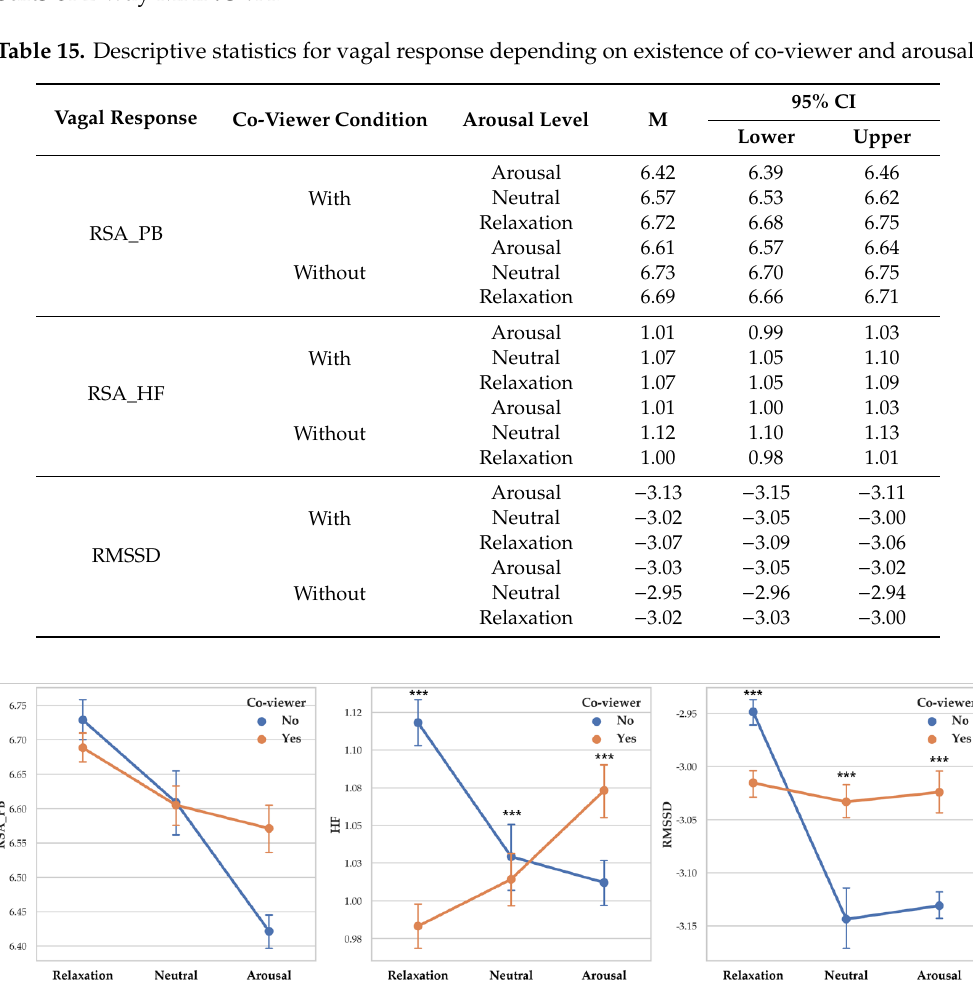
Figure 15. Point graph of vagal response depending on co-viewers and arousal levels. Point means mean of vagal responses. Asterisk means significant vagal responses difference according to co-viewer condition. (***: p < 0.001).